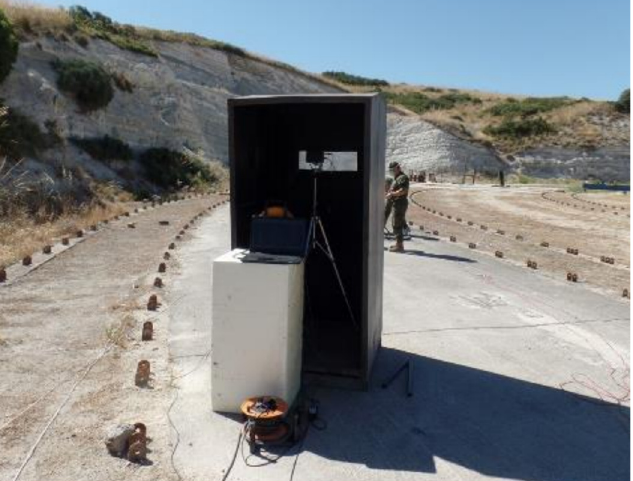
Figure 5. Assembly of the measurement system with the high-speed camera, protected behind an armored box.